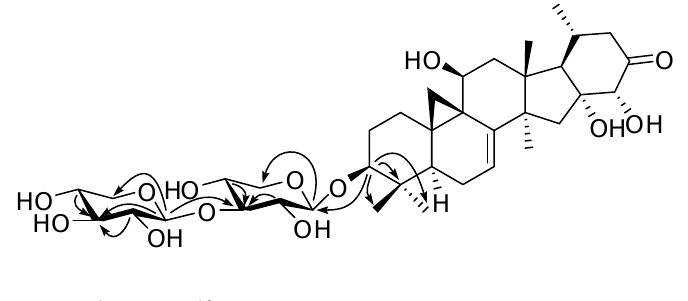
Figure 3. HMBC correlations of the disaccharide in compound 3.